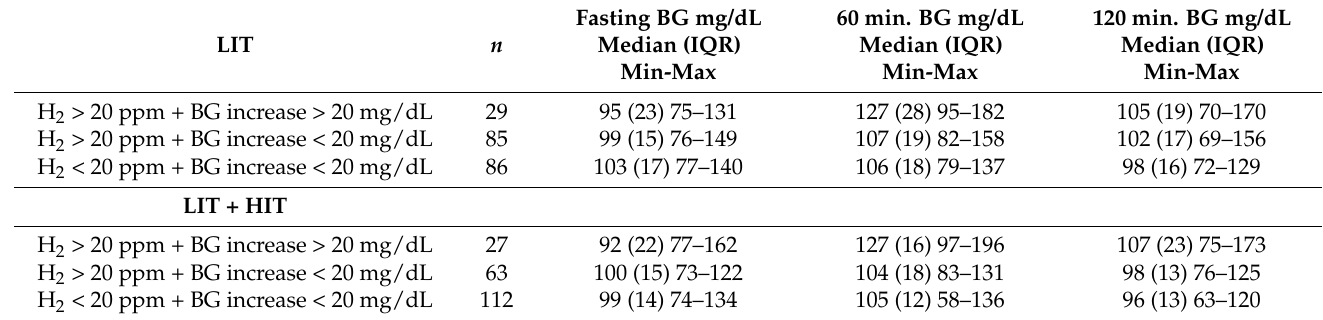
Table 1. Median blood glucose values (mg/dL) during lactose H 2 breath tests in 402 LIT